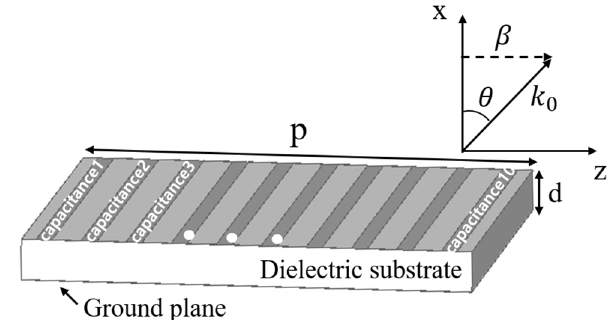
Fig. 3. A unit period of SMRS antenna composed of capacitively modulated reactance surface and its